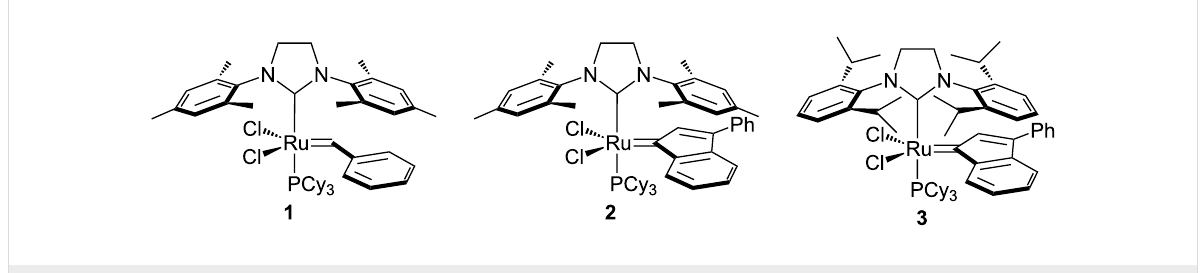
Figure 1: Representative olefin metathesis catalysts.